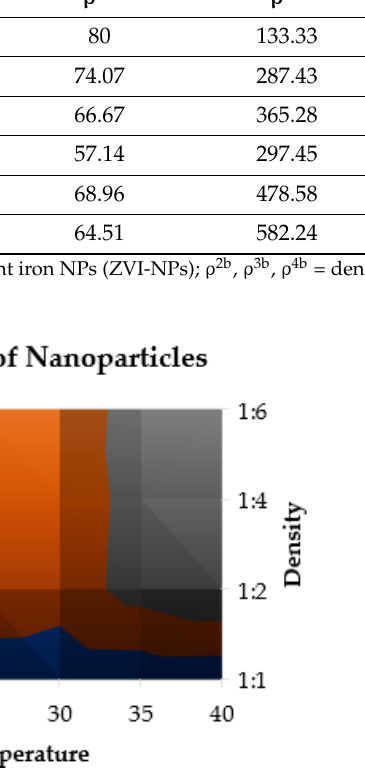
Figure 11 . Density profiling of zero - valent iron NPs at the ratio 1:1, 1:2, 1:4 , and 1:6 of the water, Figure 11. Density profiling of zero-valent iron NPs at the ratio 1:1, 1:2, 1:4, and 1:6 of the water, showing showing the distribution of ZVI - NP densities within a wastewater at varying temperature and water the distribution of ZVI-NP densities within a wastewater at varying temperature and water ratios. ratios. Table 8. Variation in density (Kg/m 3 ) as a function of solvent content and temperature.